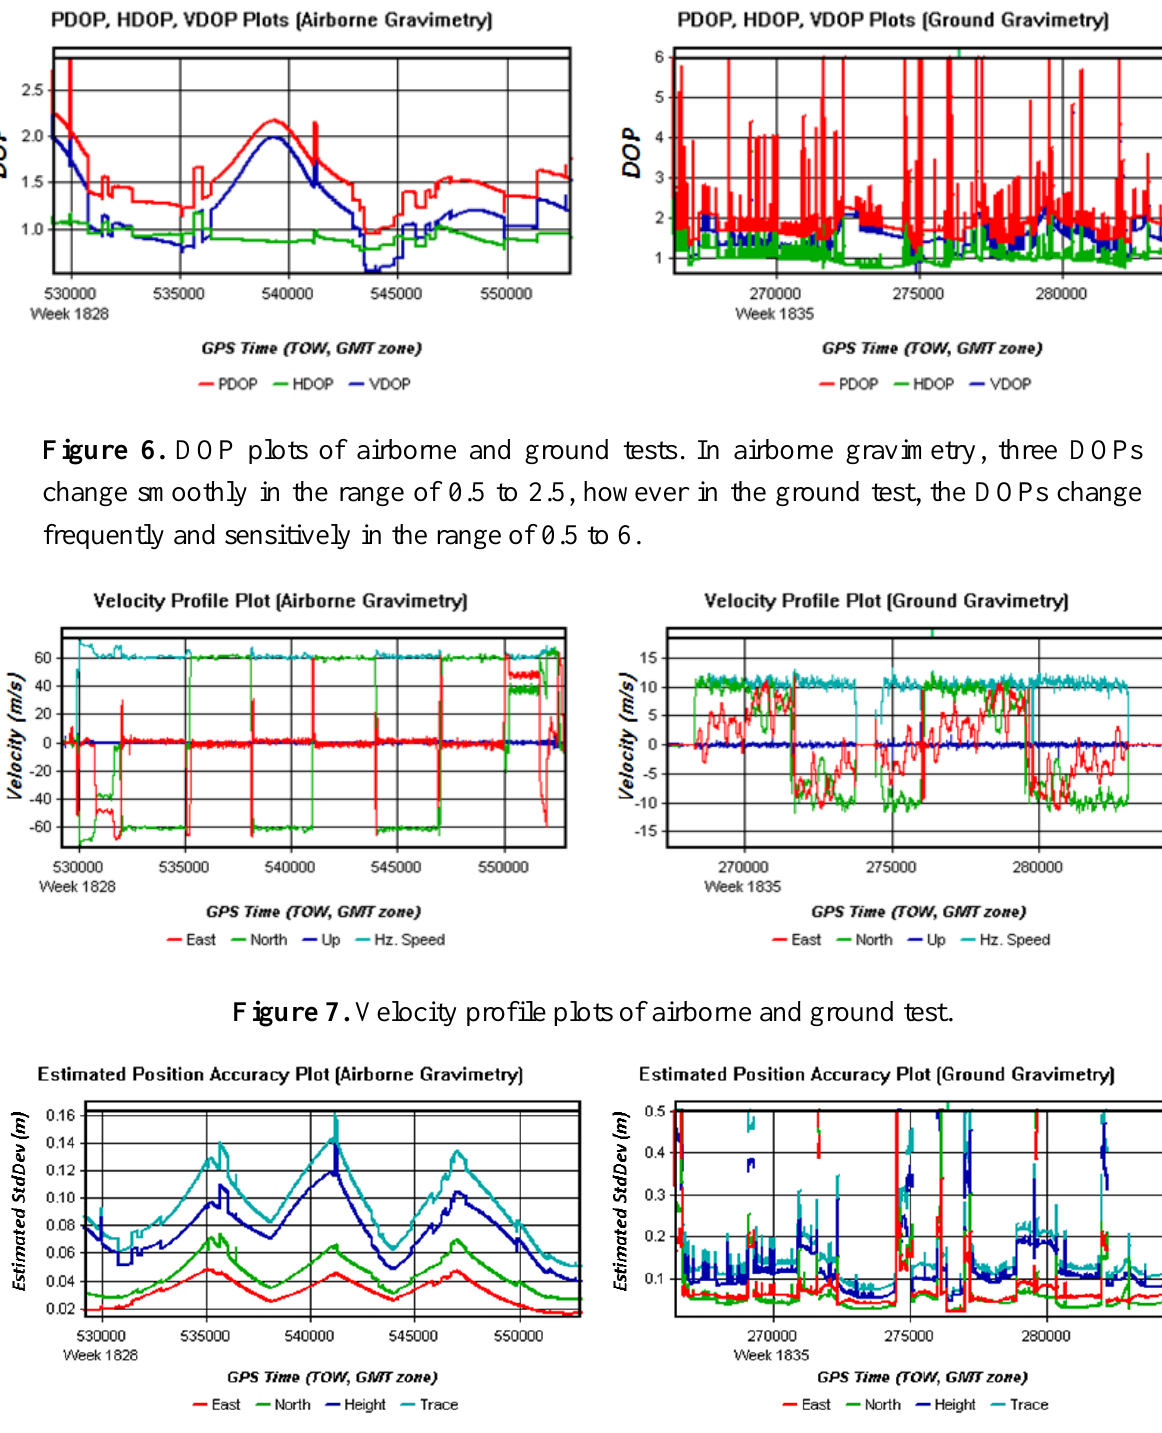
Figure 8. Estimated position accuracy plots of airborne and ground